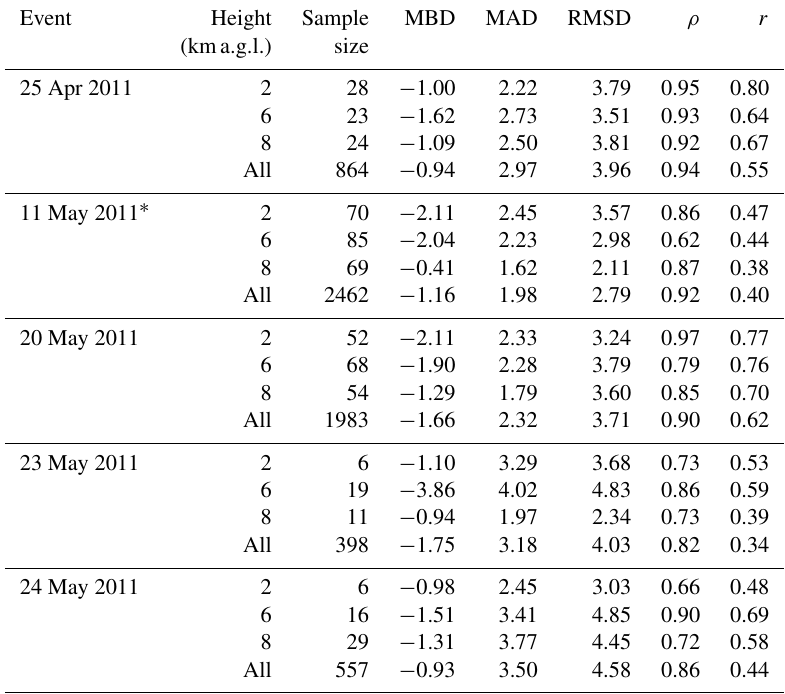
Table 5. Radar reflectivity comparisons between CSAPR-I7 and UAZR-C1 at three characteristic heights for all events. Error statistics have units of dBZ. Event